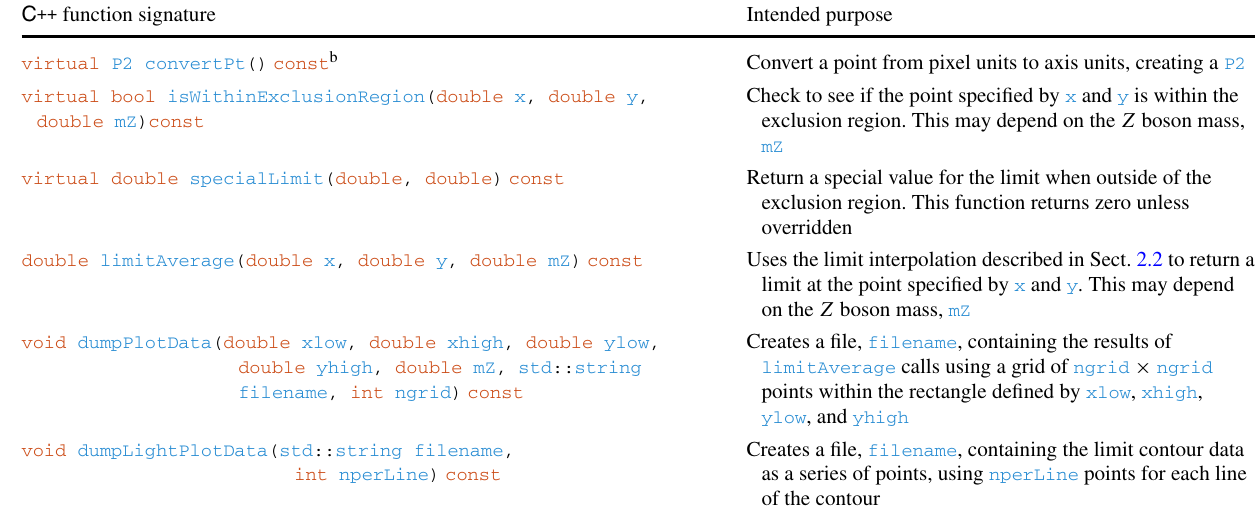
Table19 Inheritedfunctionsforsubclassesof BaseLimitContainer . Functions that are virtual and marked with b must be overrid- den by the subclass author. Non- virtual functions are not intended